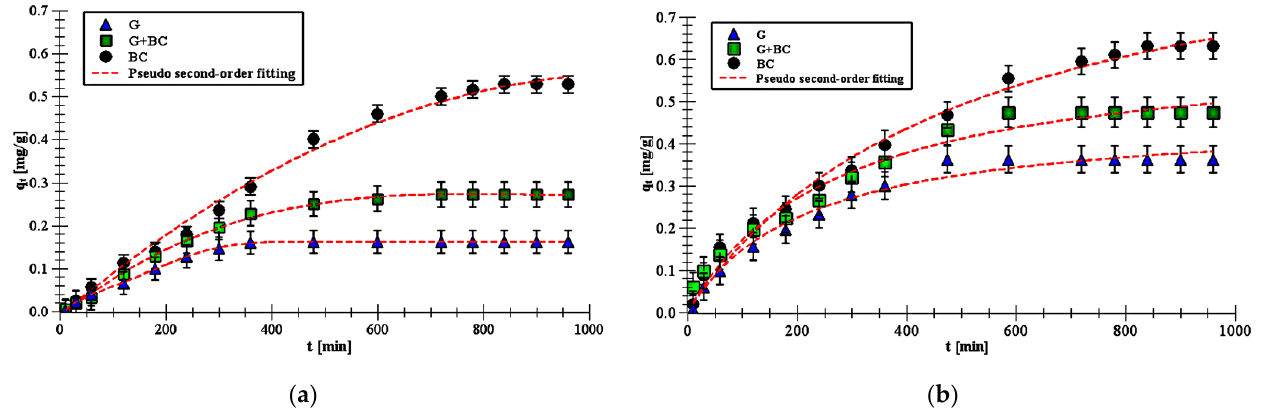
Figure 4. Adsorption kinetics data of diuron ( a ) and carboxin ( b ) on the goethite, biochar and goethite–biochar mixture (points) as well as pseudo second-order fitting (lines) at pH 6.